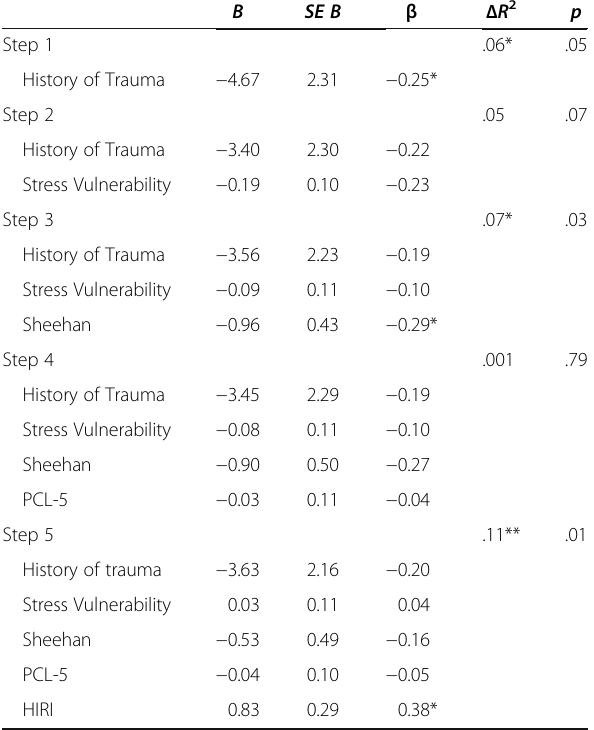
Table 4 Multiple regression analysis for critical incident coping self-efficacy at time 1